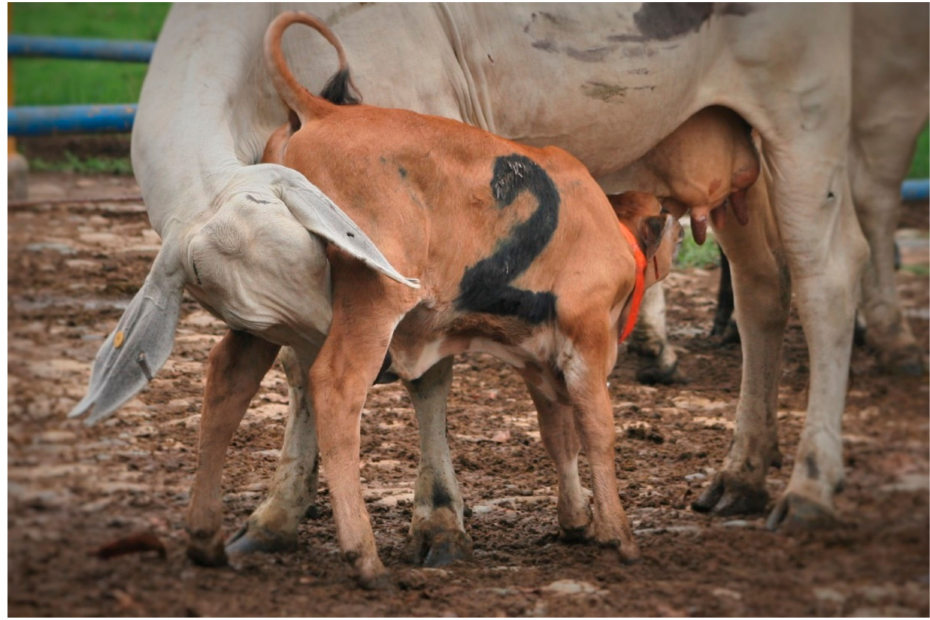
Figure 1. Postpartum cows allow their calves to suckle, which they identify through opposing signals favored by the calf’s normal suckling